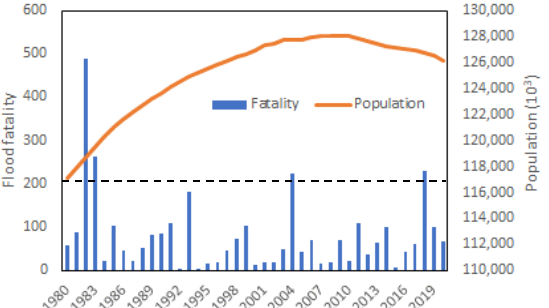
Figure 2. Flood fatality in Japan for 1980 – 2020 (Data source: e-Stat,